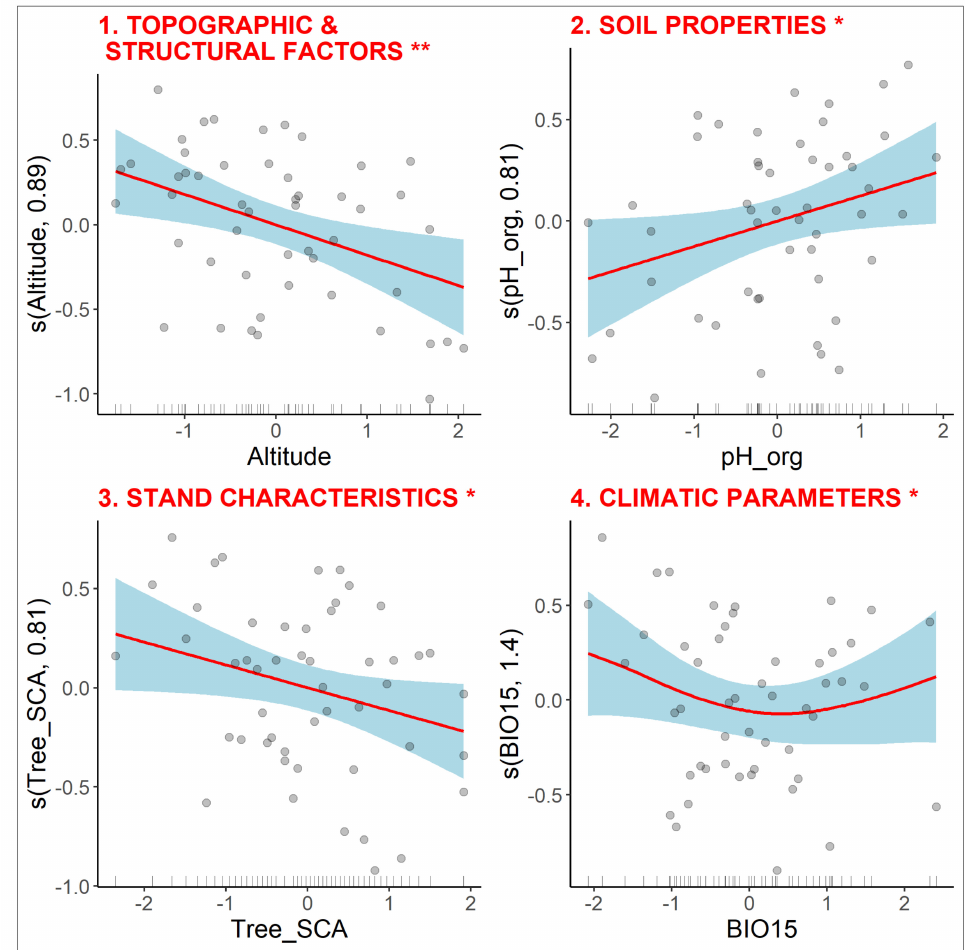
Figure 6. The estimated relationships between the diversity of bud bank traits and four explanatory variables included in the final GAM: altitude, pH of the organic soil layer, tree-layer shade-casting ability (SCA) and precipitation seasonality (BIO15). The order of predictors reflects their effect size and significance: ** p < 0.01, * p < 0.05. The confidence interval (95%) is indicated with the light-blue ribbon around each curve. For additional definition of predictors, see Table